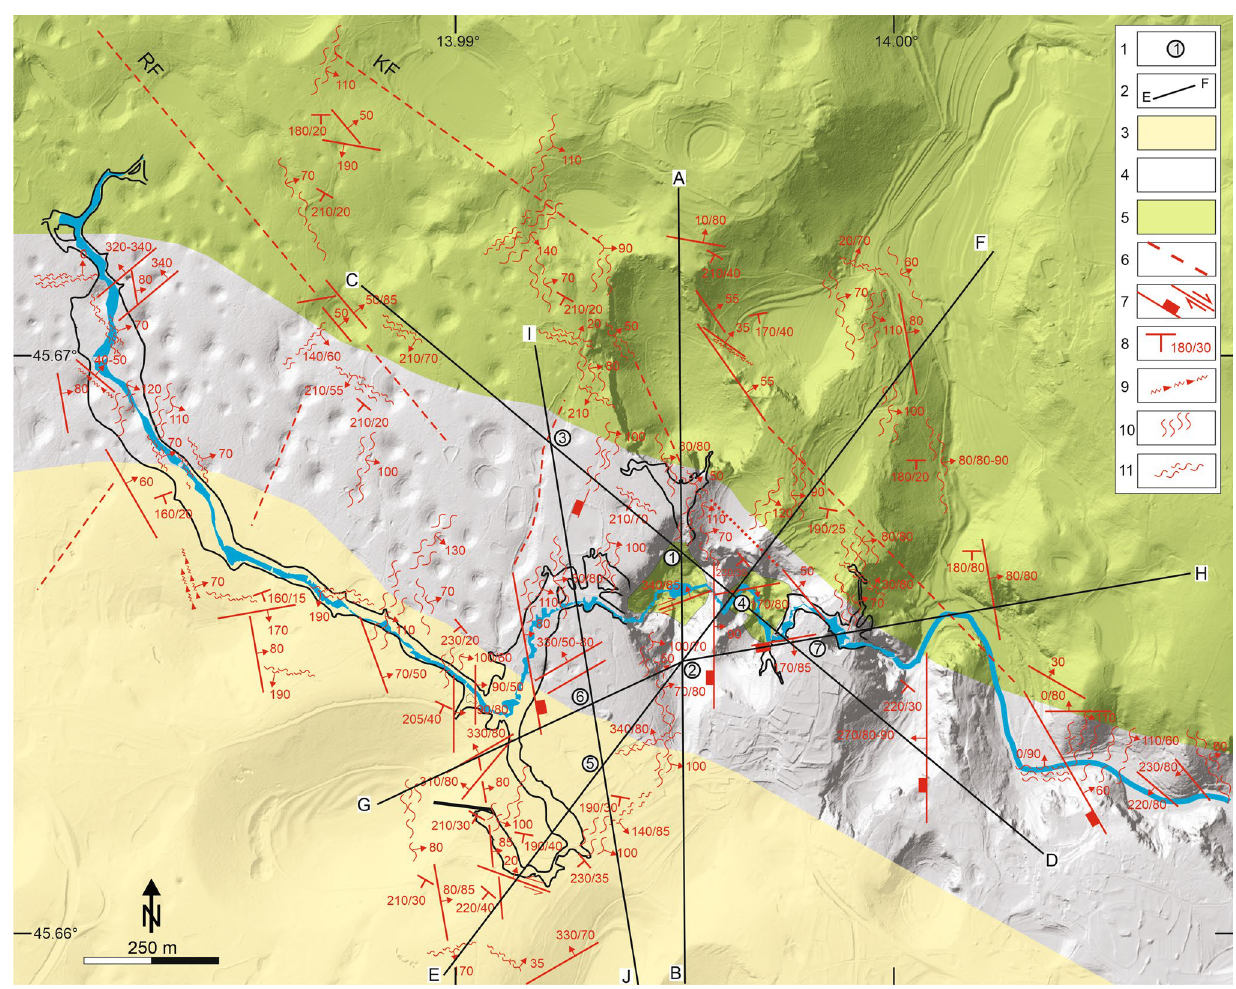
4—Lipica Formation (K 24−5 ), 5—Sežana Formation (K 22−4 ), 6—sup- posed fault trace at the surface, 7—vertical and horizontal displace- ments along faults, 8—dip direction and dip angle of bedding planes, 9—crushed zone, 10—broken zone, 11—fissured